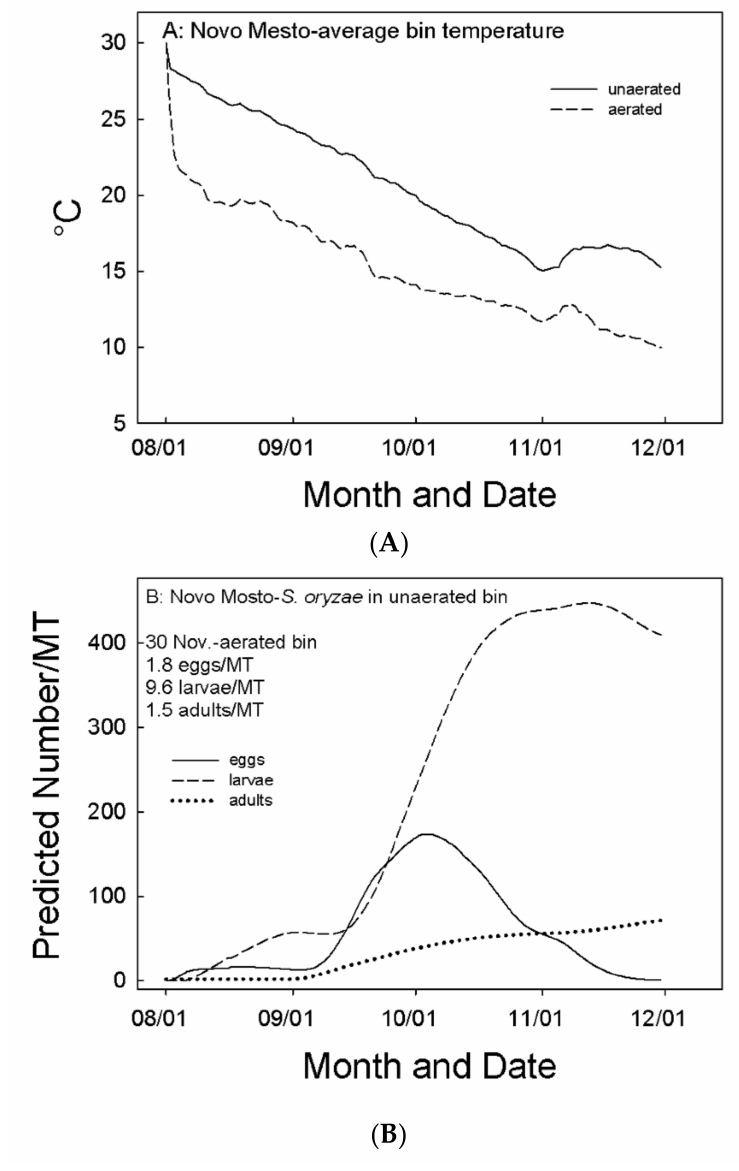
Figure 3. Predicted average bin temperatures in unaerated and aerated wheat stored in Novo Mesto, Slovenia from 1 August to 30 November ( A ); and predicted numbers of eggs, larvae, and adults of Sitophilus oryzae in unaerated wheat ( B ). Predicted numbers of each life stage on November 30 in aerated wheat are listed as text ( B ). In the X-axes, date is given in Month-Day